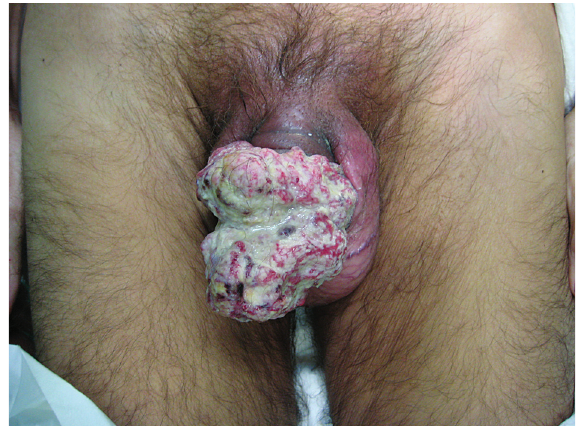
Figure 3 – Penile tumor in an Israeli Jewish patient, who had undergone neonatal circumcision (religious ritual known as